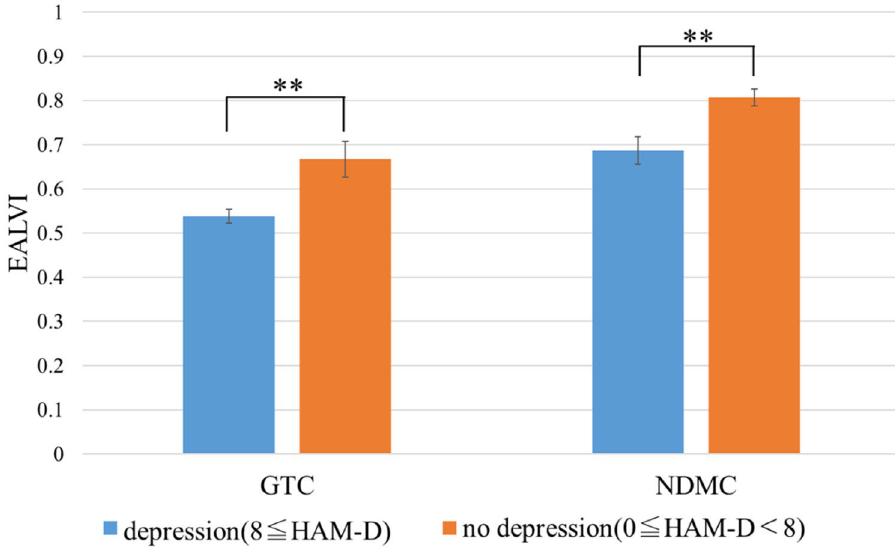
Figure 4. The mean EALVI value for the “depression” and “no depression” groups, by facility. Note : Error bars represent standard error. **( p < 0.01).